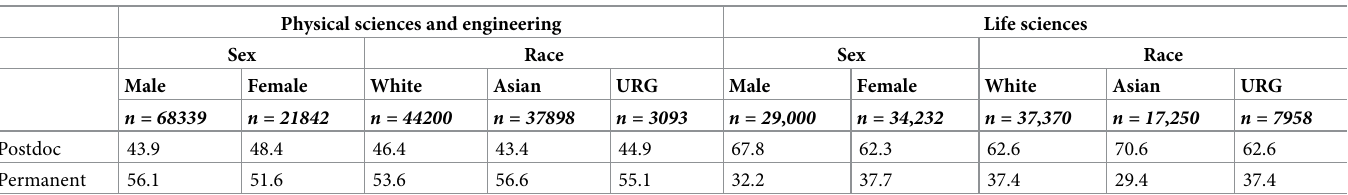
Table 4. Percentage of employment type by sex and race from 2009 to 2018.